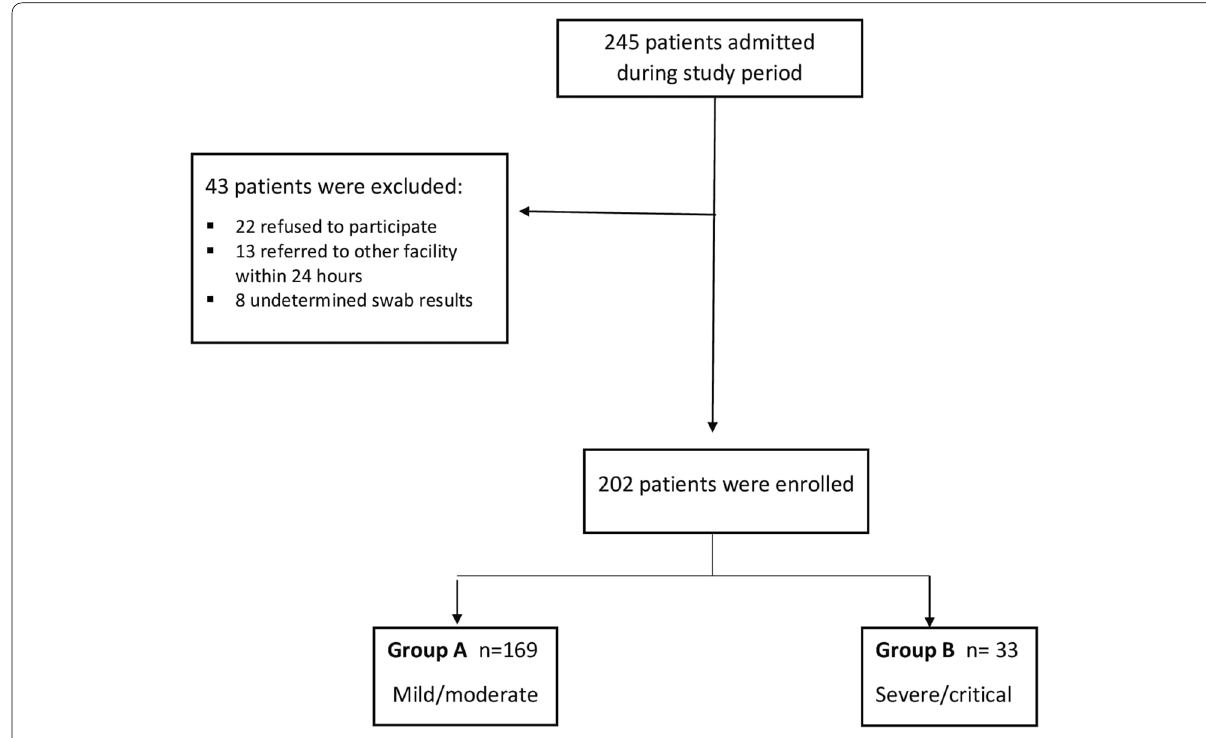
Fig. 1 Flow chart of the studied population